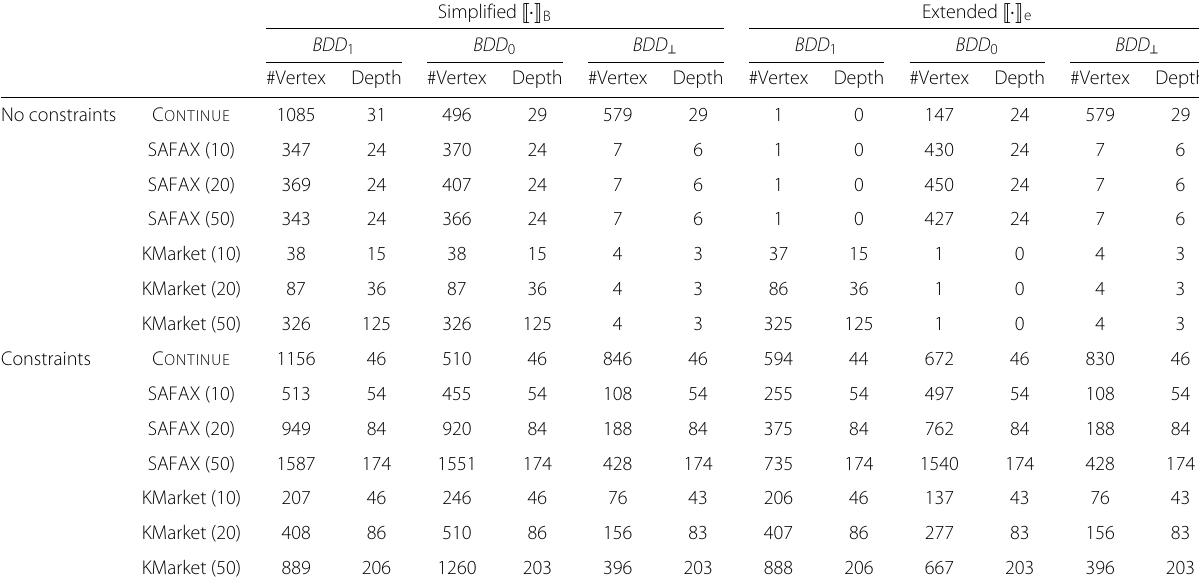
Table 6 Overview of the BDDs encoding the simplified (cid:2) ⋅ (cid:3) B and extended (cid:2) ⋅ (cid:3) e evaluation with/without